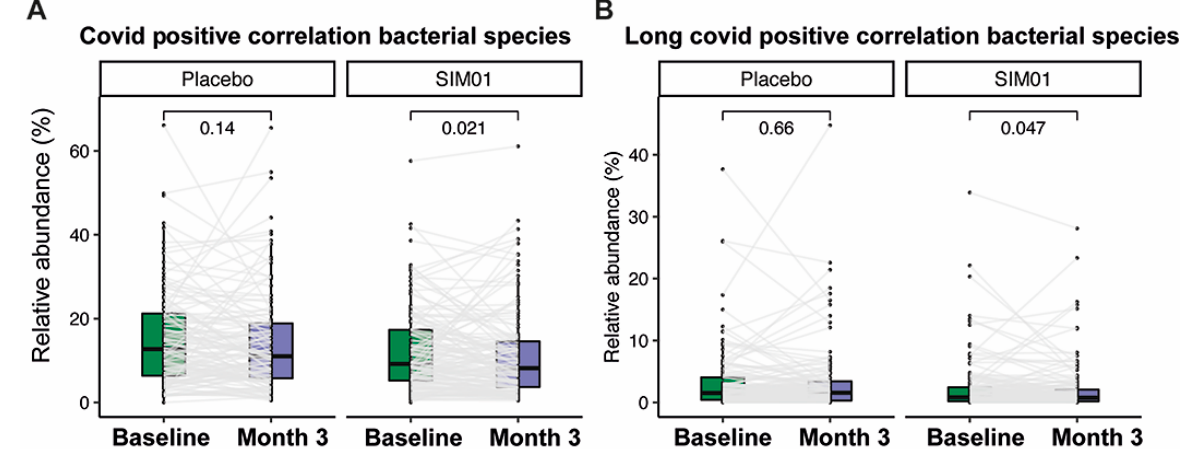
Figure 5. The abundance of pathogenic bacterial species enriched in COVID-19 or Long COVID was significantly decreased at month 3 in the SIM01 arm (placebo baseline, n = 123; placebo 3 months, n = 123; SIM01 baseline, n = 135; SIM01 3 month, n = 135). Elements on boxplots: centre line, median; box limits, upper and lower quartiles; points, each sample; grey line, the same paired subject.